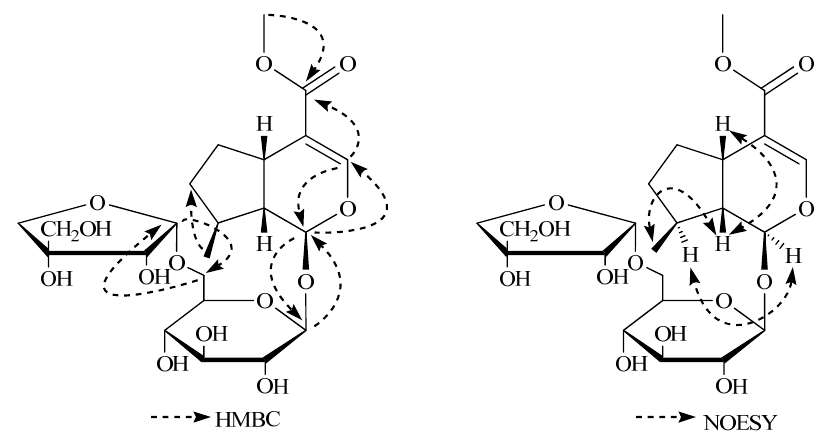
Figure 1. Key HMBC and NOESY correlations of 1 .